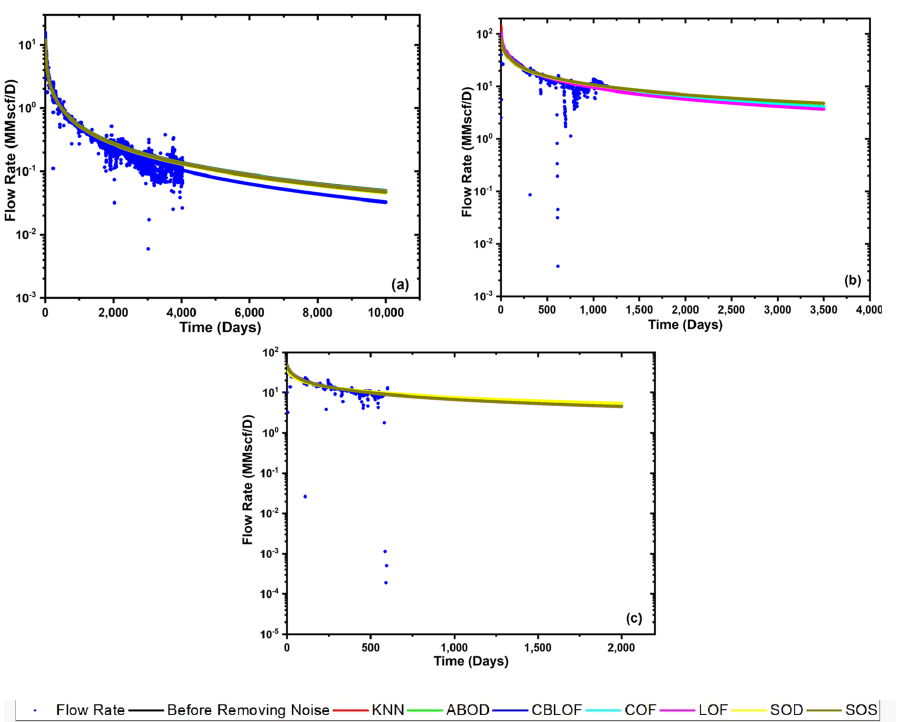
Figure 24. Applying VEDM decline model before and after removing noise using the seven OD algorithms for; ( a ) Well_12, ( b ) Well_29, and ( c ) Well_40.